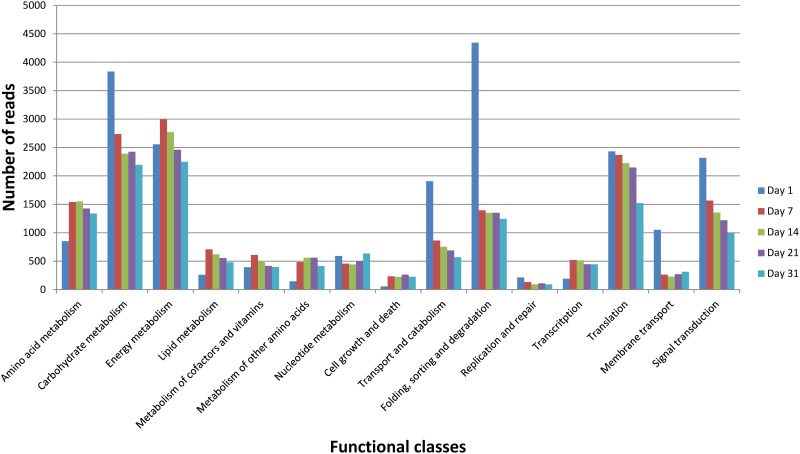
Functional classification of the metatranscriptome during surface-ripened cheese maturation.Functional classes were determined according to KEGG annotations. Read counts corresponding to all species were cumulated. Read numbers were normalized (according to the library size) to 50,000 reads per sampling day.